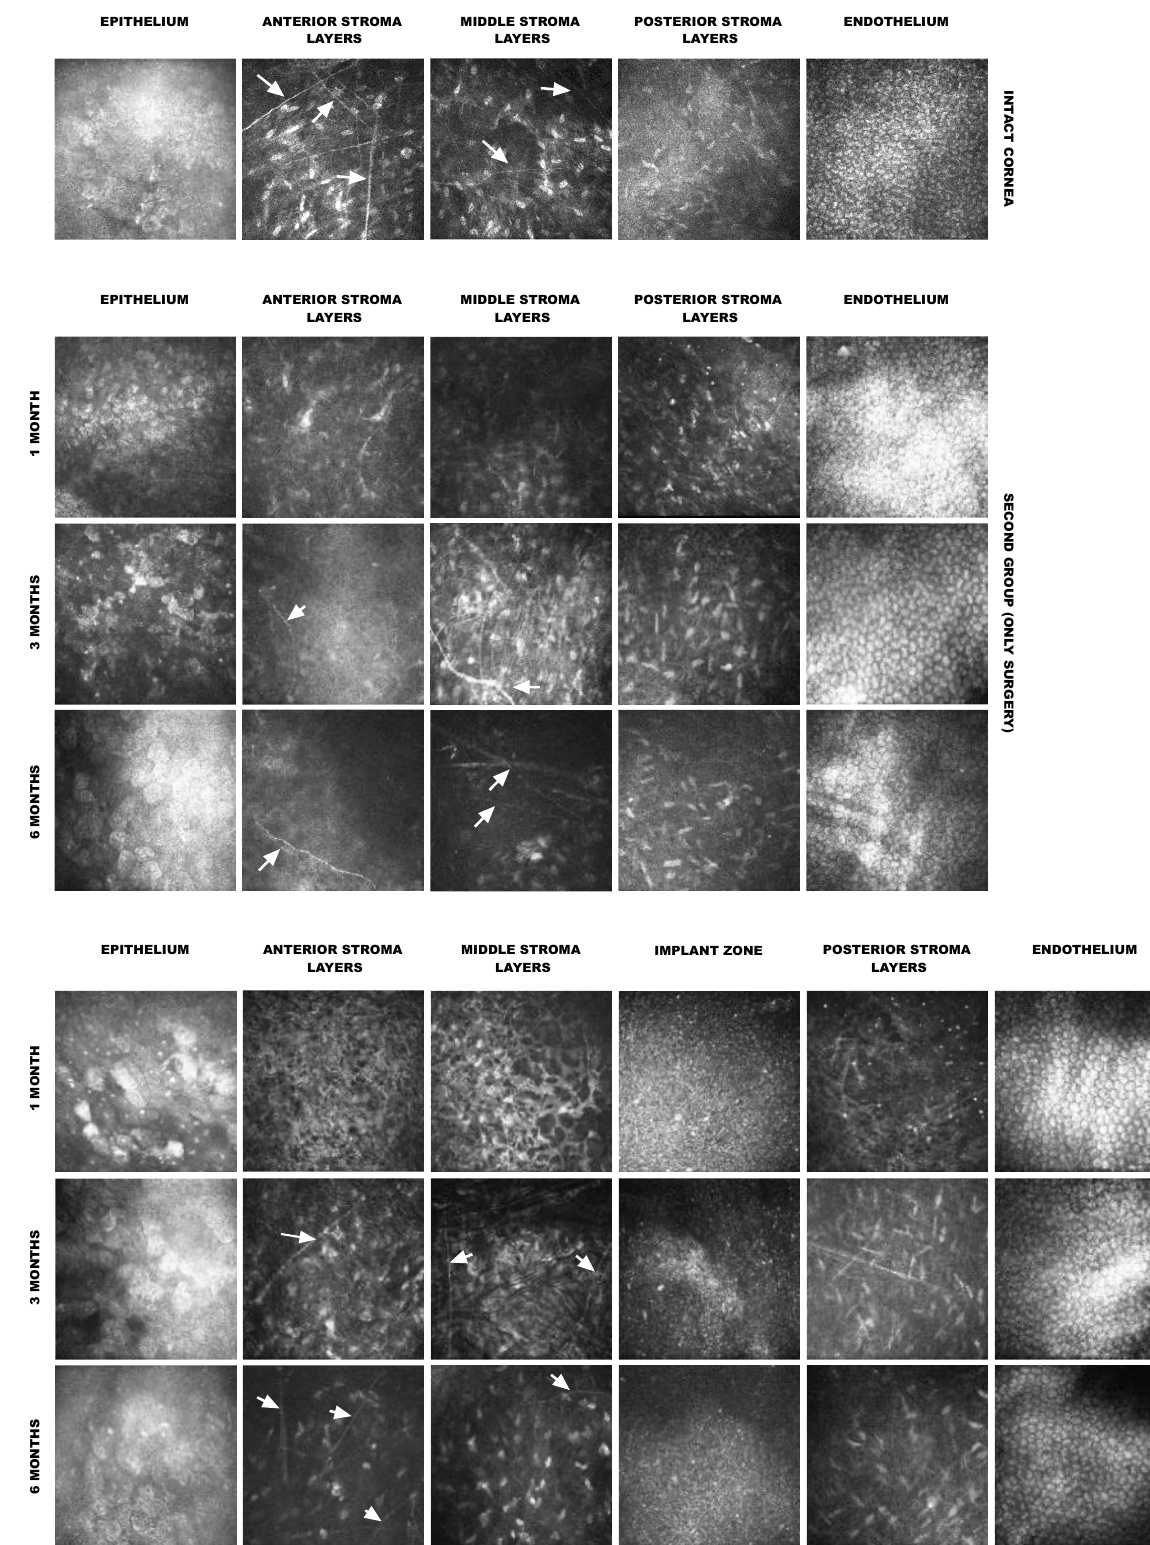
Figure 5. In vivo confocal microscope images of rabbit corneas implanted with the collagen mem- brane at different observation times. Arrows indicate nerves.